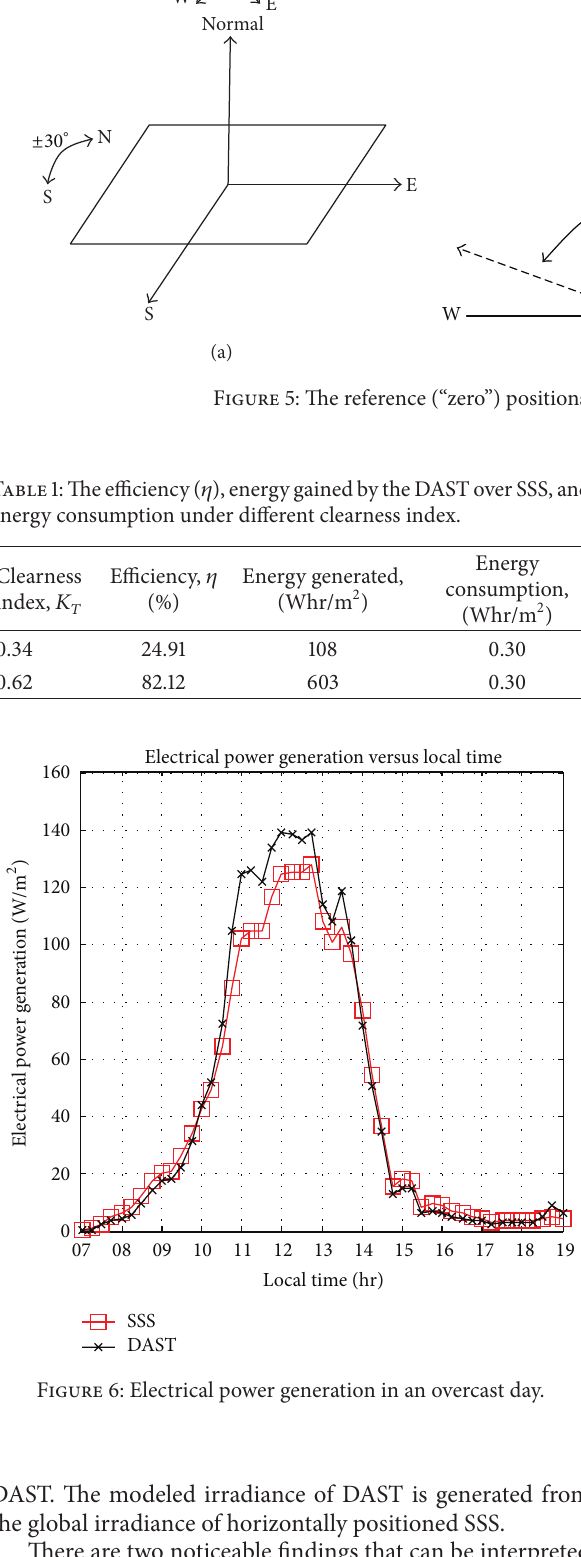
DAST. The modeled irradiance of DAST is generated from the global irradiance of horizontally positioned SSS.